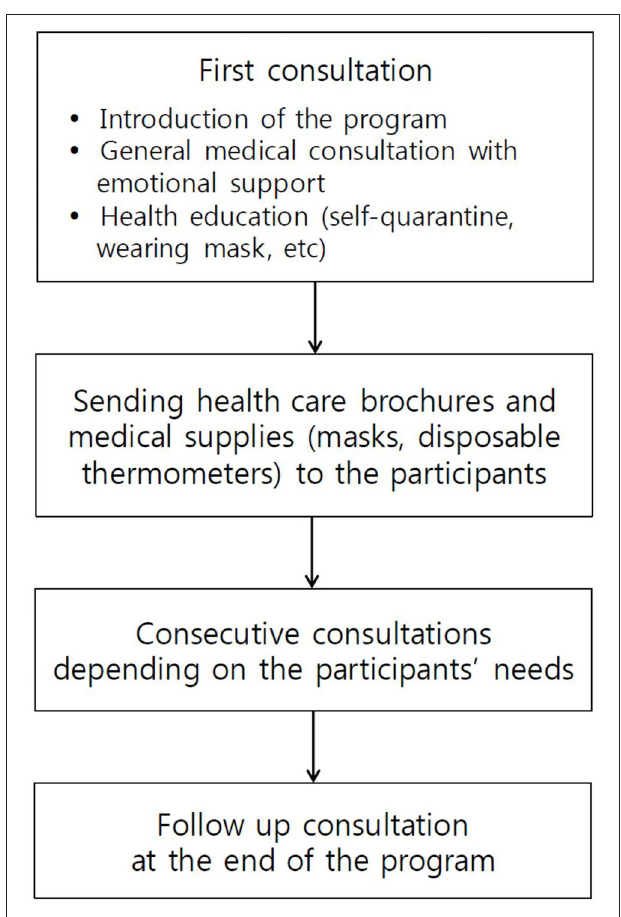
FIGURE 2 | Flowchart of the health counseling program after recovery from the Coronavirus disease 2019